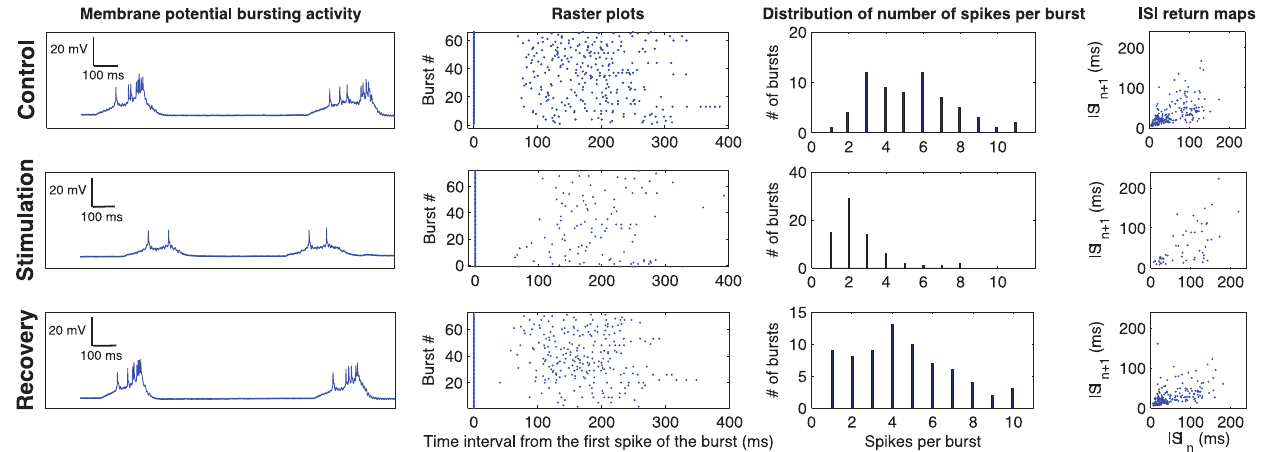
Figure 4. Results of the activity-dependent drug stimulation protocol. The rows on the first column show the membrane potential time series during control (top row), stimulation (middle row) and recovery after washout (bottom row). The rows on the second column show the raster plots for control (top), stimulation (middle) and recovery (bottom). The rows on the third column show the distribution of the number of spikes in each burst for the three time series. Finally, the panels on the fourth column show the inter-spike intervals (ISI) return maps during control (top), stimulation (middle) and recovery (bottom). Note that during the stimulation, the number of spikes per burst drastically decreased because of the RT activity-dependent GABA microinjections.